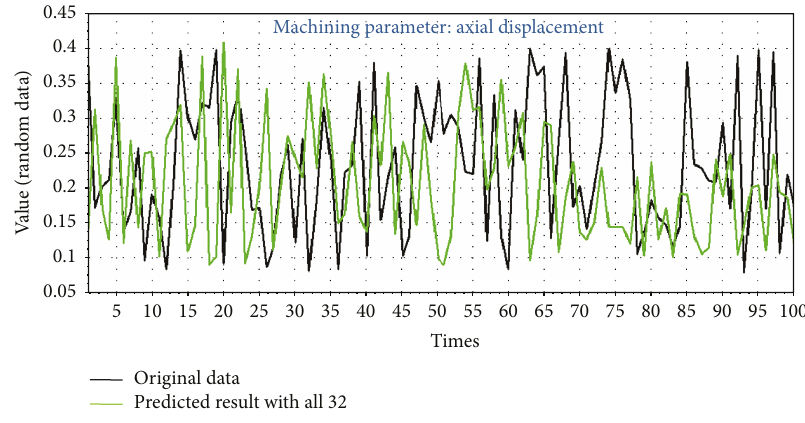
Figure 26: Predicted results of axial displacement of grinding wheel.